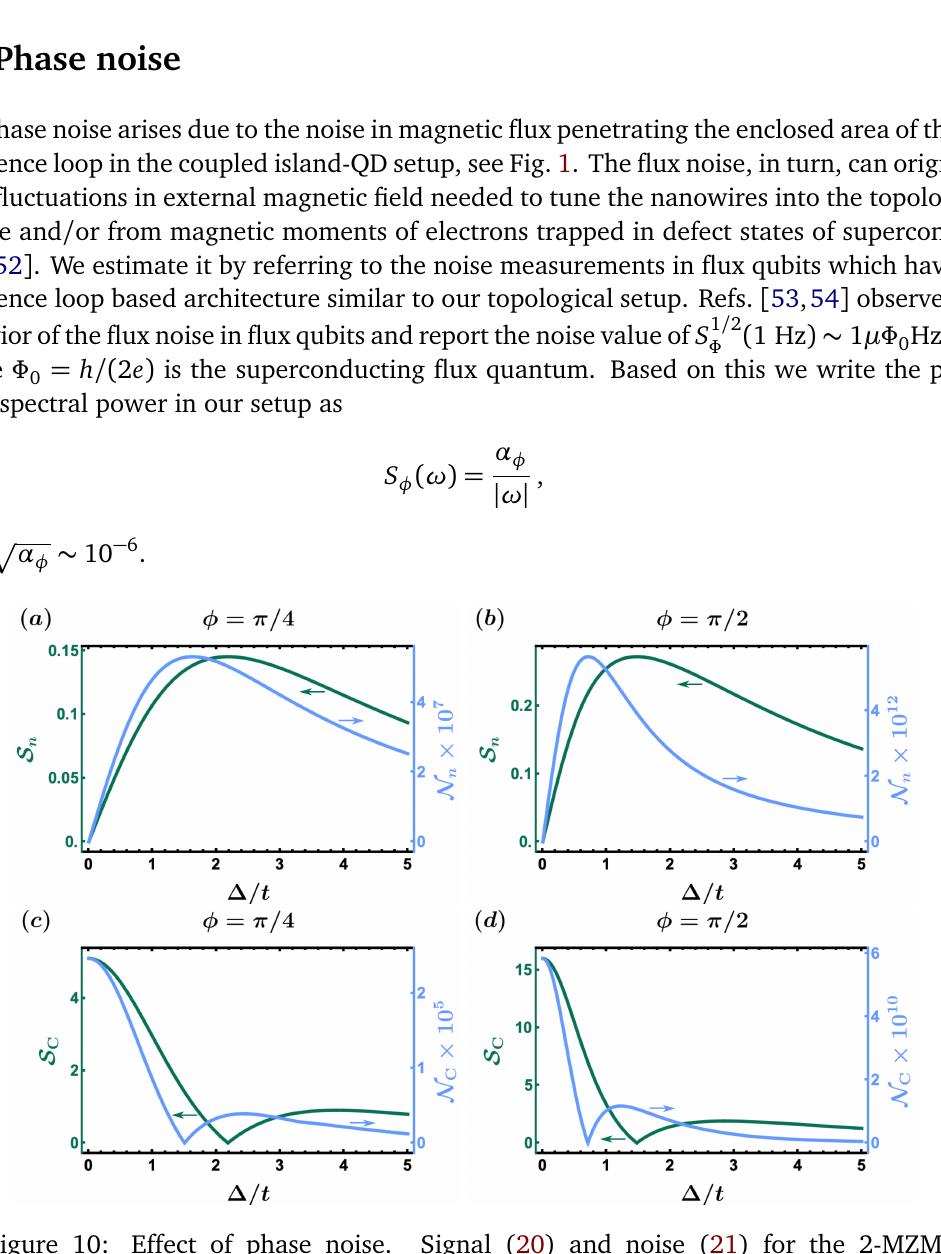
〉 (a)-(b) and differential QD ca- QD ∆ for different values of